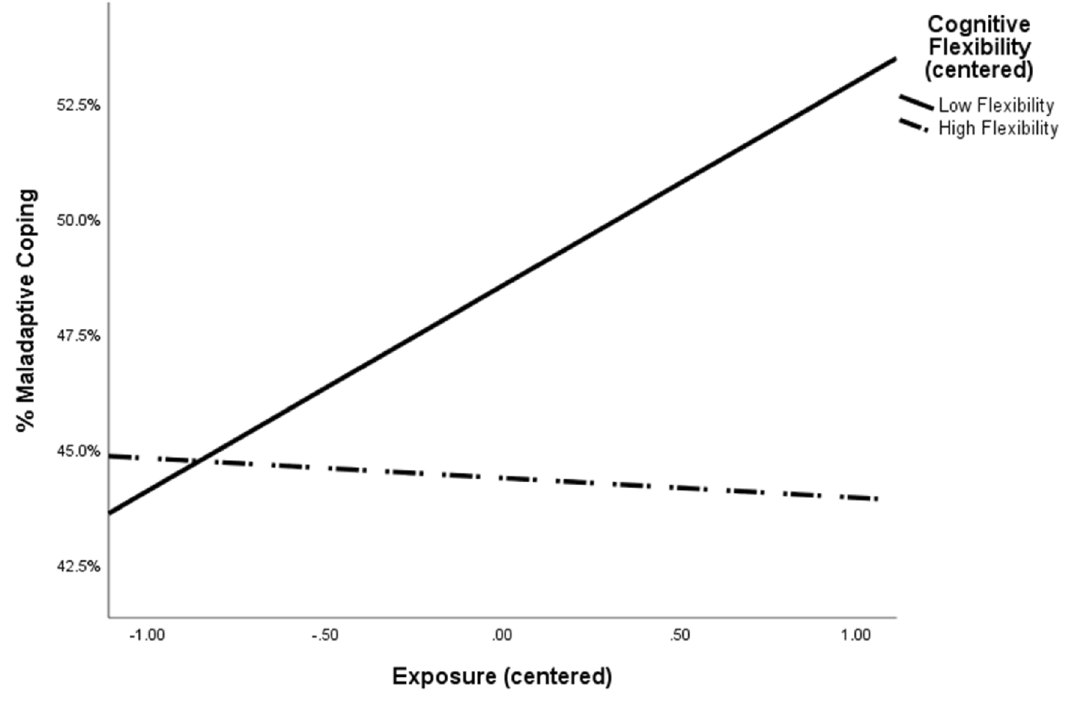
Figure 2. The interactive effect of school-related stress exposure and cognitive flexibility on maladaptive